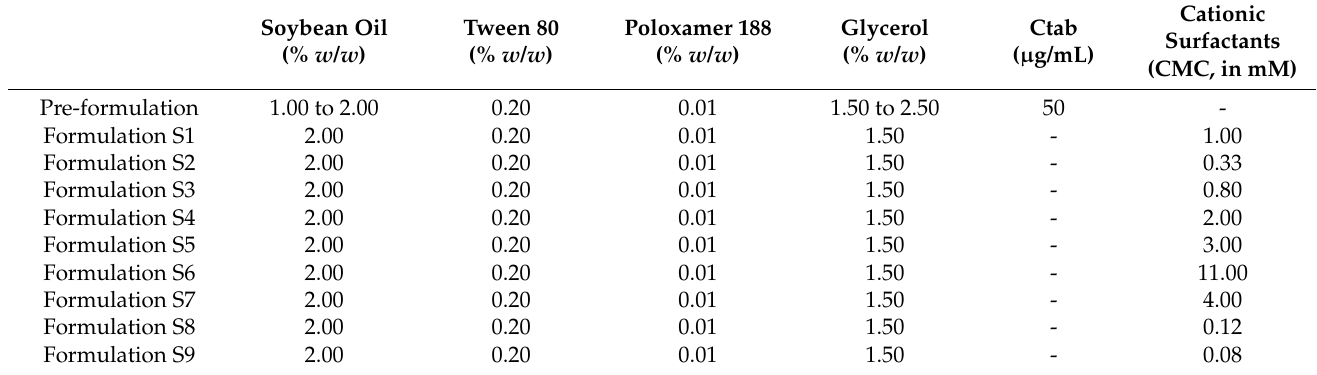
Table 1. Composition of the developed nanoemulsions containing CTAB or a cationic Surfactant 1 to 9 (S1 to S9, for structure see Figure 1) (caption: CMC, critical micelle concentration).